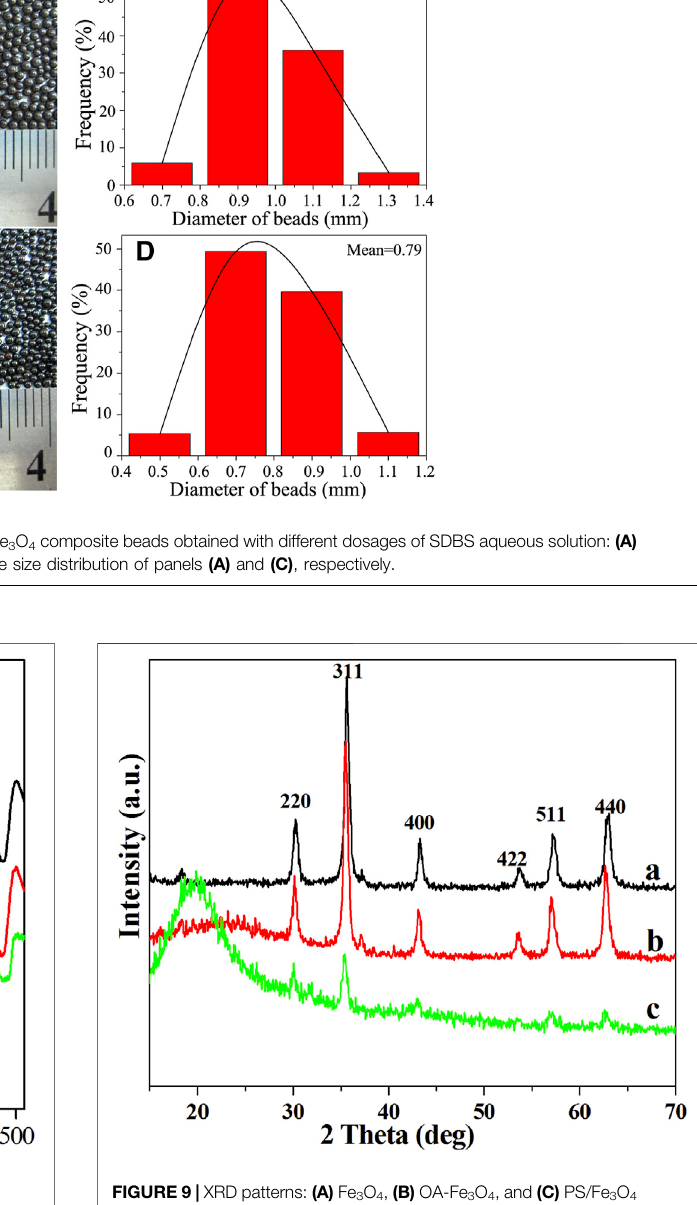
Fe 3 O 4 composite